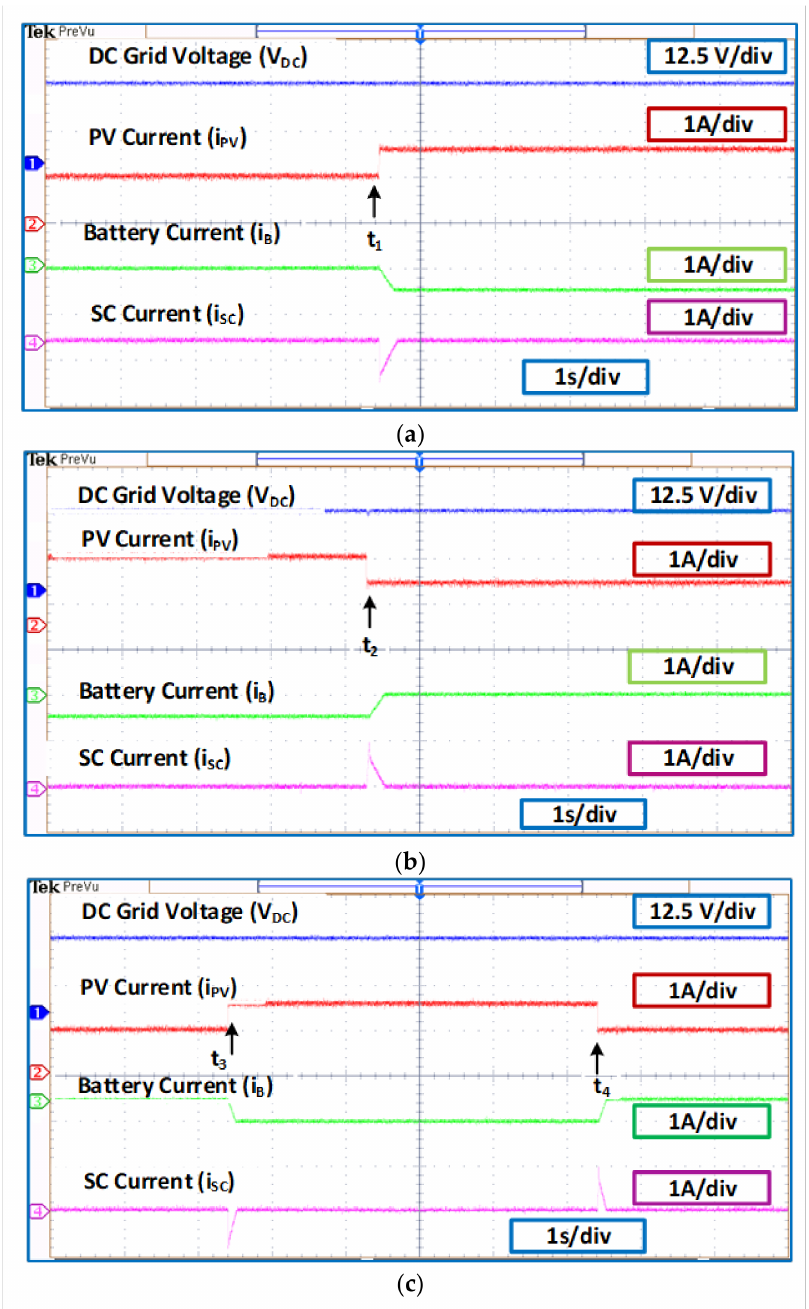
Figure 19. Experiments on a step change in PV production have yielded promising results. ( a ) Step increase in PV generation, ( b ) step decrease in PV generation and ( c ) step increase and decrease in PV